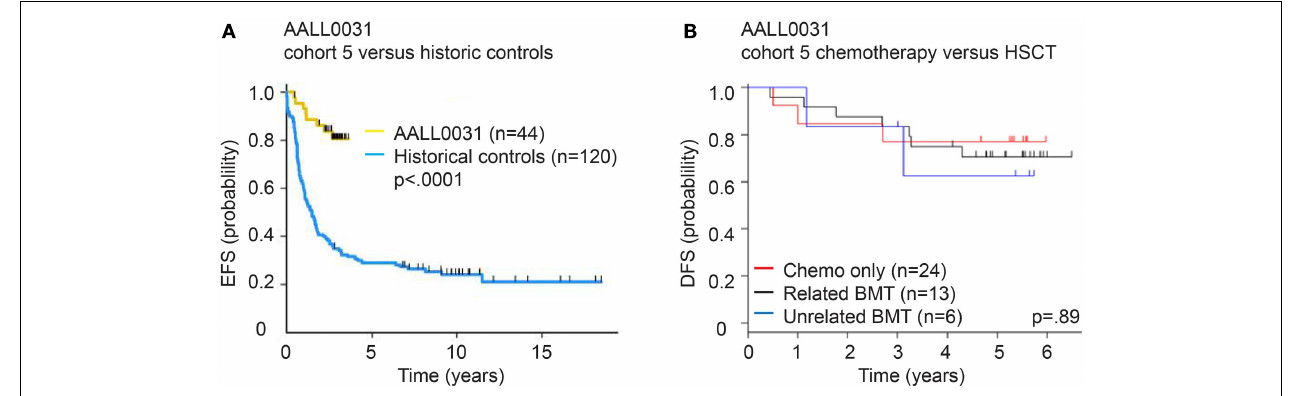
backbone of standard chemotherapy dramatically improved the outcome of Ph + ALL. (B) Disease-free survival (5.2-year median follow-up) of patients treated as per AALL0031 cohort 5 based on transplant status. Chemotherapy only – 24 patients, matched related HSCT on study – 13 patients, unrelated HSCT off study – 6 patients. HSCT did not offer additional benefit compared to chemotherapy +